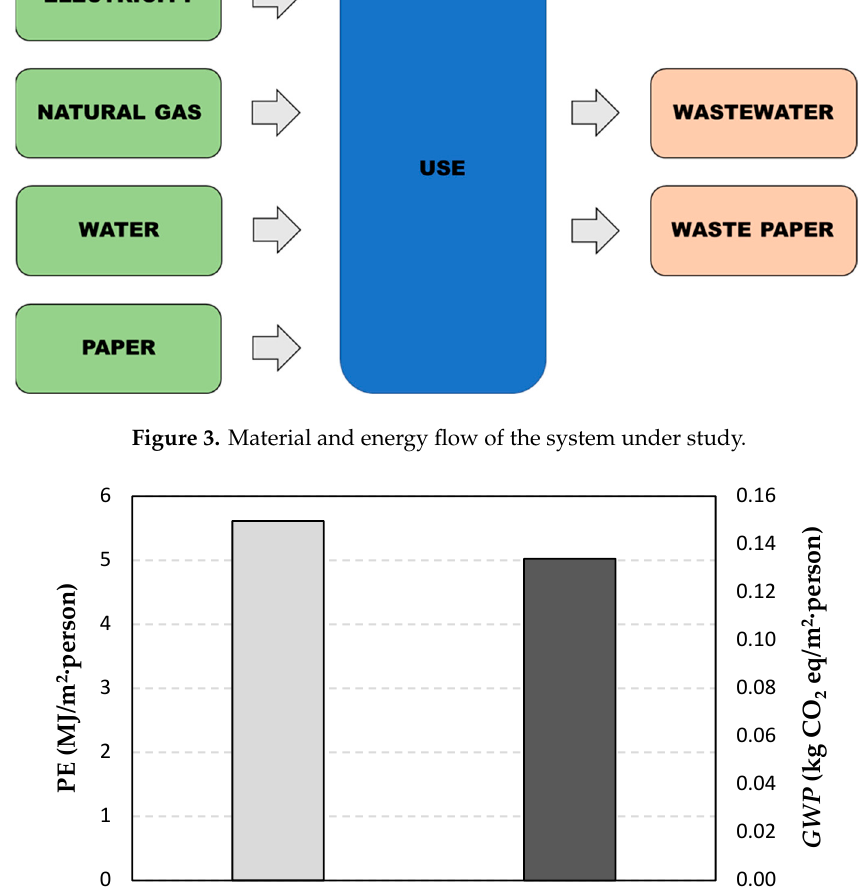
Figure 3. Material and energy flow of the system under study.